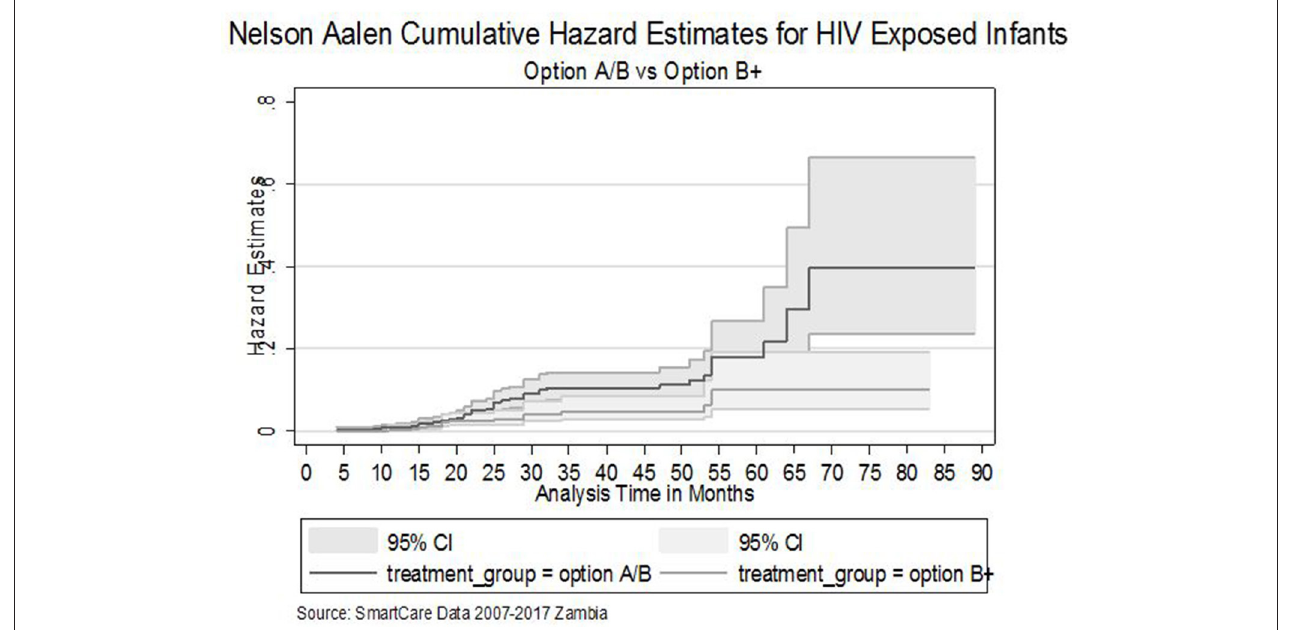
FIGURE 2 | The Nelson Aalen cumulative hazard estimates for HIV exposed infants by treatment groups.